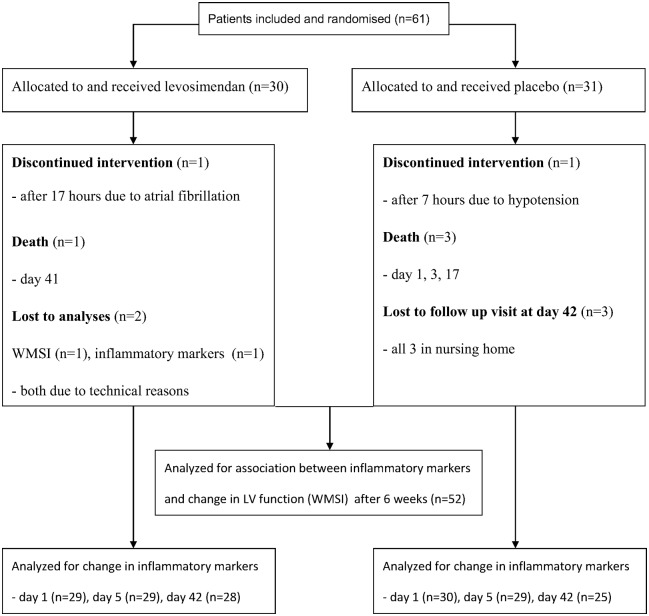
Study-flow diagram of included patients.